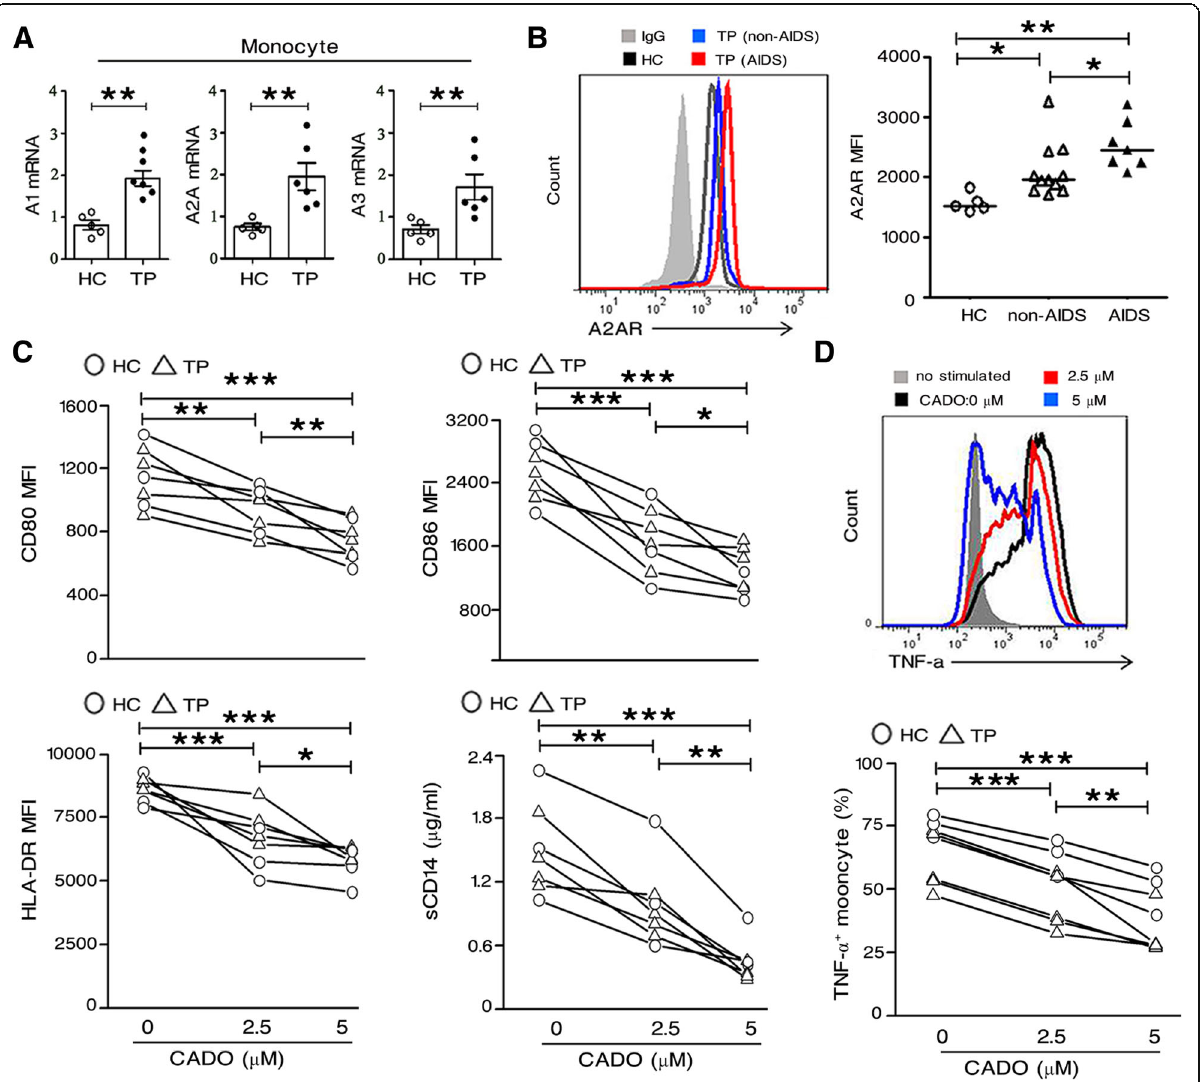
Fig. 5 The expression of adenosine receptors in monocytes and inhibition of the activation of monocytes by adenosine. a RT-PCR results are shown for relative expression of A1R, A2AR, and A2BR in monocytes isolated from HCs ( n = 5) and TPs ( n = 7). b MFI values of A2AR expressed on monocytes were higher in patients with AIDS. c Pooled data showing the expression levels of CD80, CD86, and HLA-DR on monocytes, and sCD14 released from monocytes in response to CADO under stimulation with LPS. d Pooled data showing the TNF- α expressing monocytes in response to various concentrations of CADO under stimulation with LPS. * p < 0.05, ** p < 0.01, *** p <